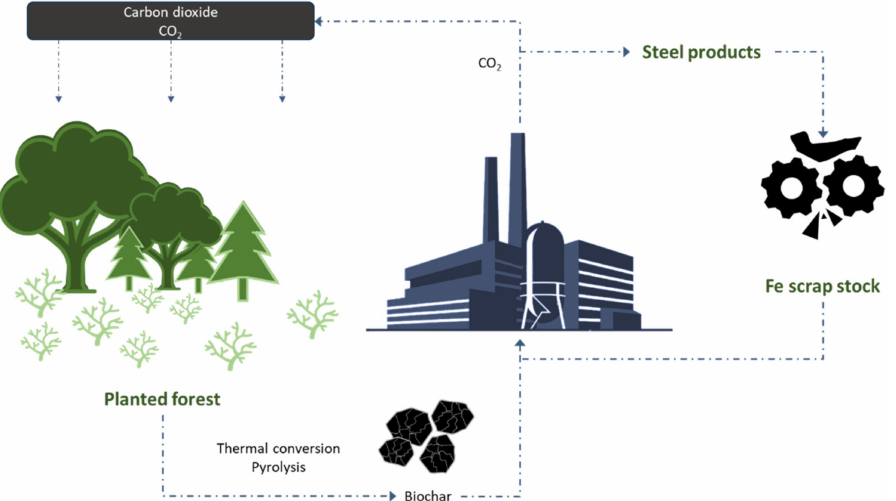
Figure 2. Utilization of biochar in iron and steel